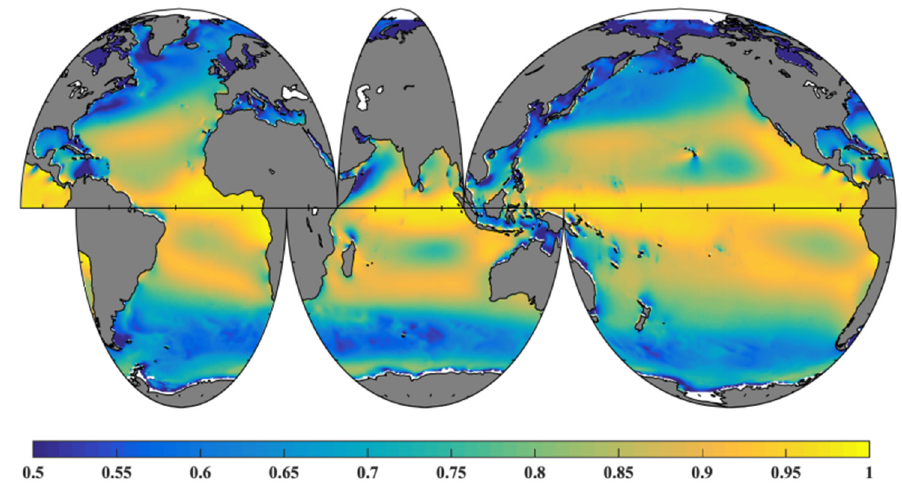
Figure A4. Swell index (1979–2019) for the global oceans from ERA5.